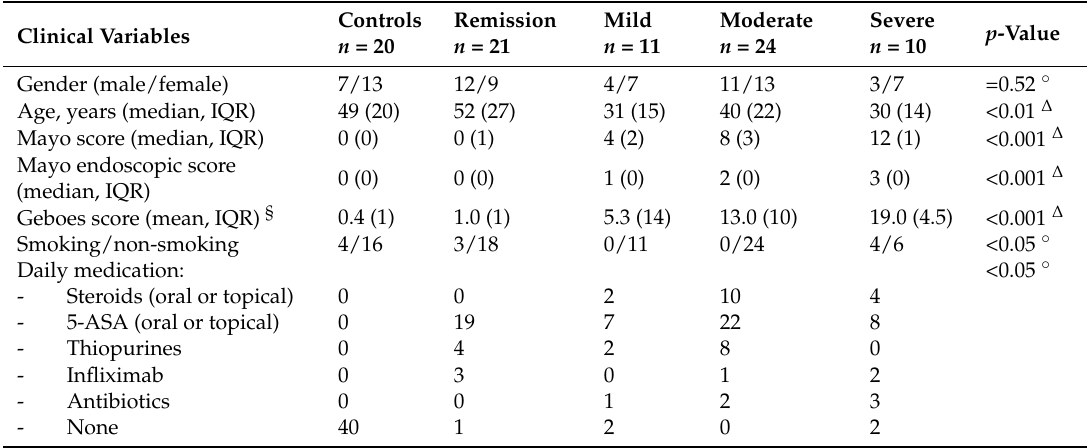
Table 1. Demographic data and disease characteristics of ulcerative colitis (UC) patients and controls. Clinical Variables